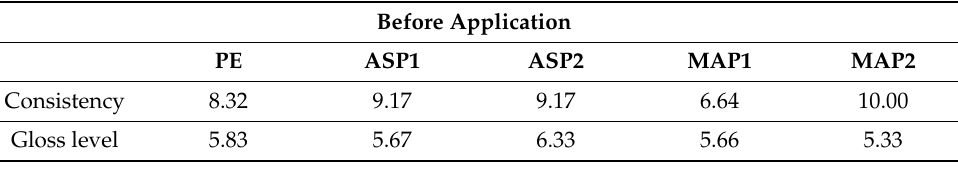
Figure 6. In vivo determined mean values with a standard deviation of melanin index (MI) for non- treated control (NC), placebo emulgel (PE) and investigated emulgels (ASP1, MAP1, ASP2 and MAP2) after 3 and 7 days of application. Significant differences are marked with * ( p < 0.05).